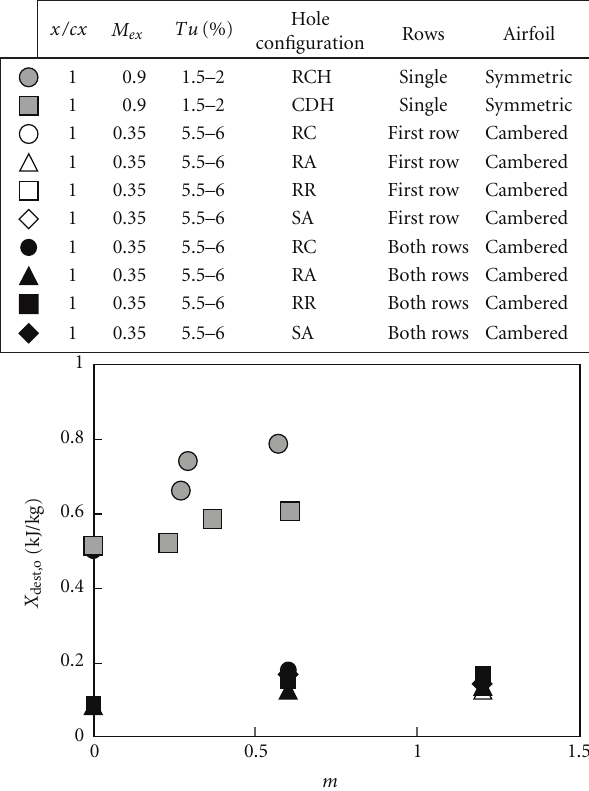
Figure 28: Overall exergy destruction as it varies with film cooling blowing ratio as measured one axial chord length downstream of di ff erent smooth airfoils with di ff erent exit Mach numbers, and di ff erent film cooling configurations and